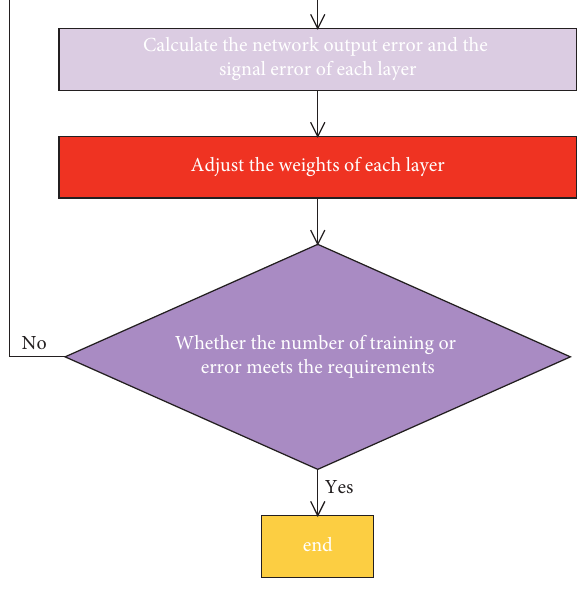
Figure 4: Algorithm